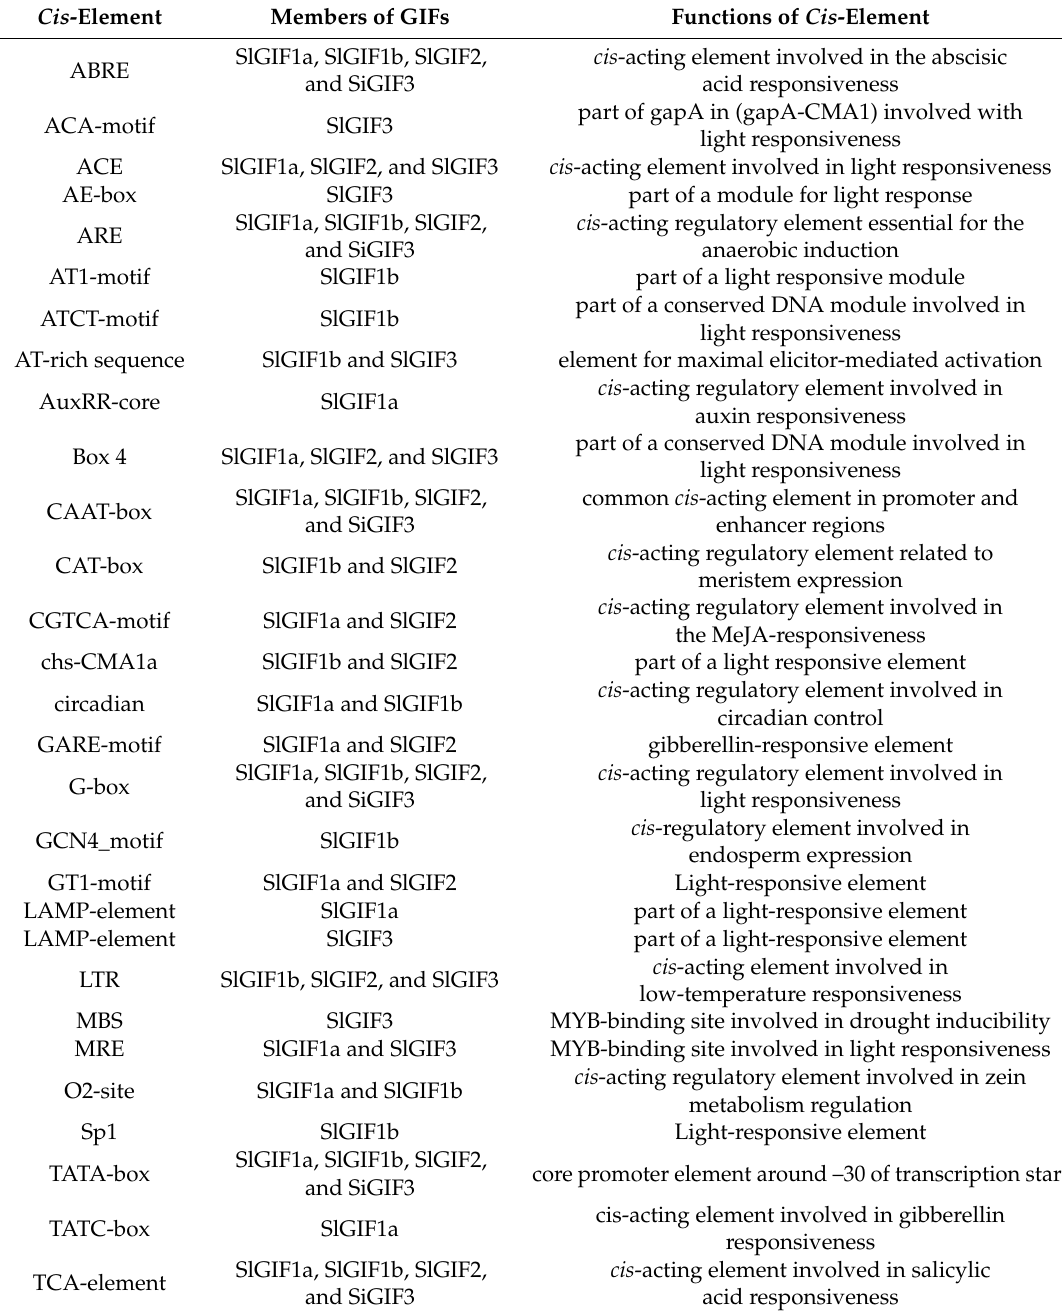
Table 2. Functionally described cis -elements identified in the promoters of the SlGIF